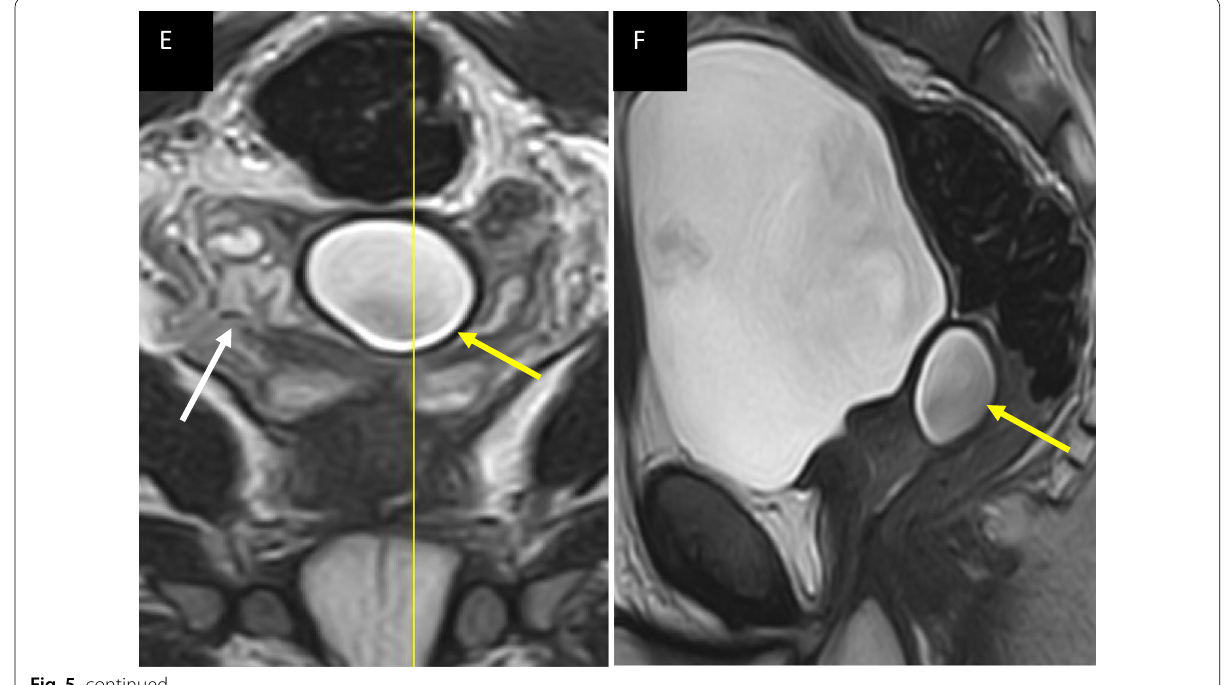
Table 1 Semen analysis of the infertile cases Parameter